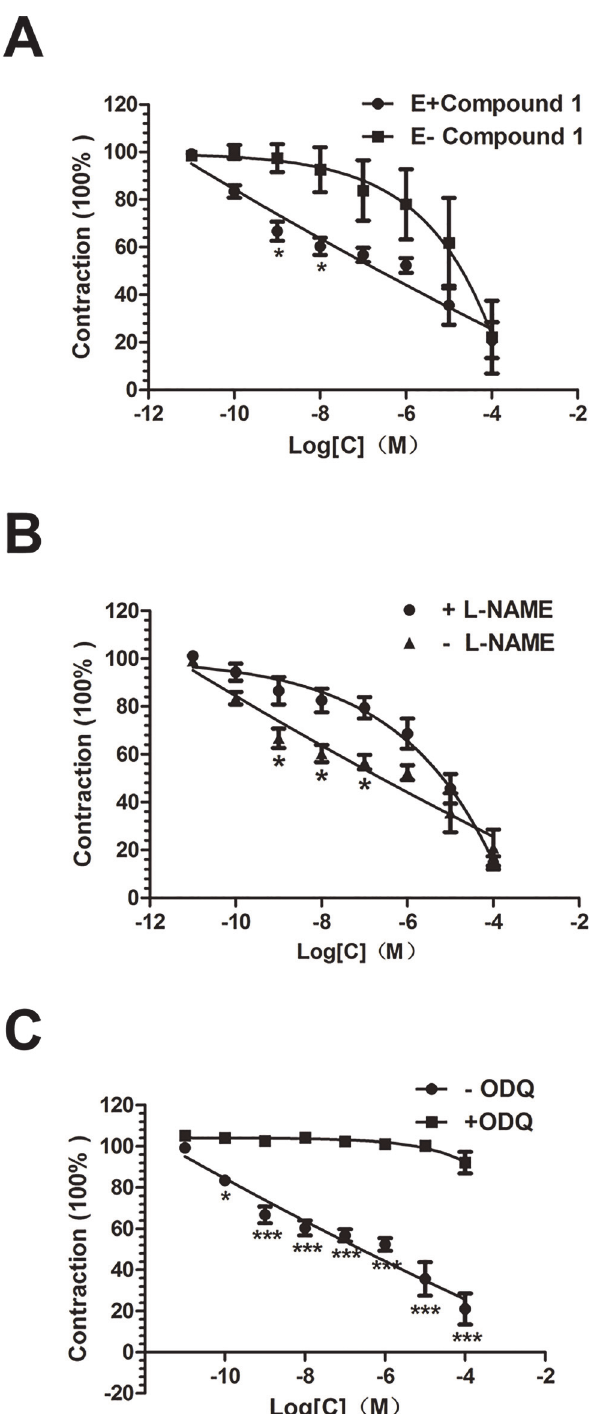
Fig 4. Compound 1-induced endothelium-dependent and-independent relaxations. a. The differences between compound 1 -induced endothelium-dependent and — independent relaxation. b. Effects of L-NAME (1uM) on compound 1 -induced relaxation in endothelium-denuded aortic rings. c. Effects of ODQ (1uM) on compound 1 -induced relaxation in endothelium-denuded aortic rings. Results are presented as mean ± S.E.M., n = 6, * P < 0.05, ** p < 0.01, *** P < 0.001 compared with compound-only group.